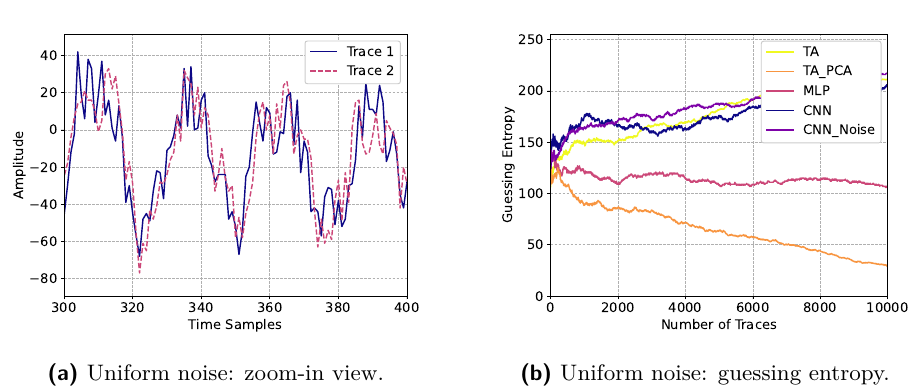
Figure 16: Uniform noise: demonstration and its influence on guessing entropy. Algorithm 6 Add Uniform Noise.